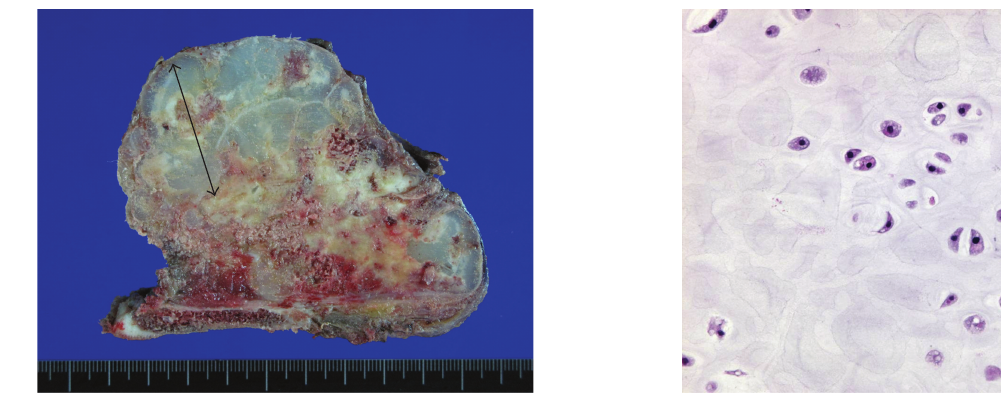
Figure 9: Secondary CHS arising in osteochondroma. Note the thickening of cartilage cap (2.5cm, arrows).